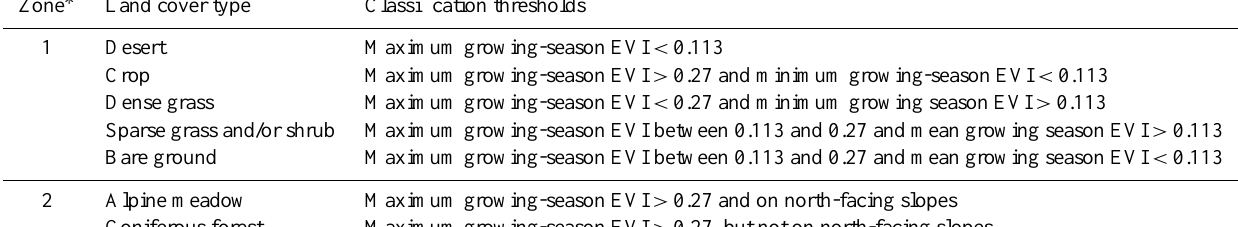
Table A1. Land cover type definition as a function of elevation zone, enhanced vegetation index (EVI), and slope orientation. Zone